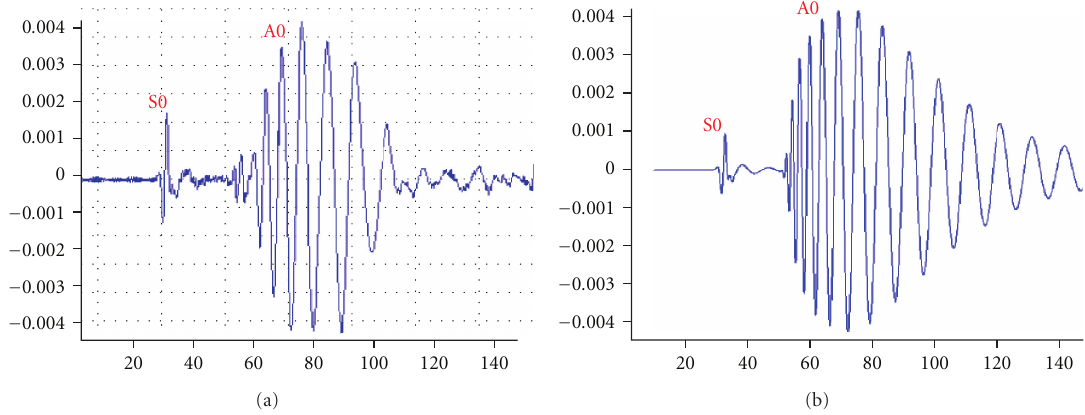
Figure 5: PWAS response compared to theoretical prediction. (a) PWAS waveform; (b) theoretical out-of-plane displacement by